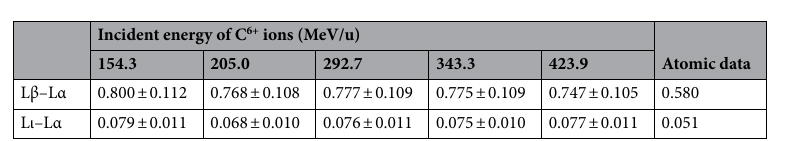
Table 2. Relative intensity ratio of Au L-subshell x ray induced by high energy C 6+ ions.